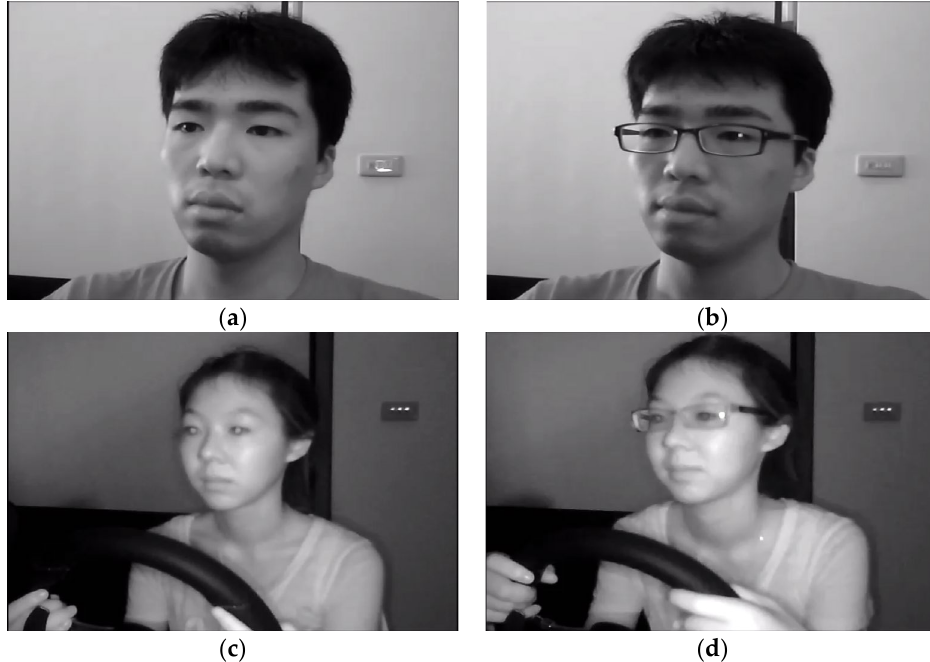
Figure 11. NTHU dataset with different states with glasses and without glasses: ( a , c ) NDHU-DDD sample without glasses; ( b , d ) NDHU-DDD sample with glasses [33] .